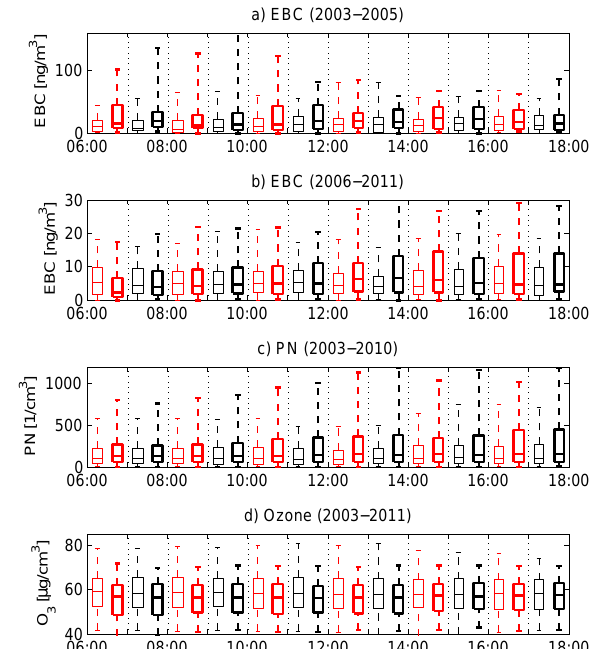
Fig. 5. Box and whisker plots of EBC, particle number concentra- tion for the 60nm size bin, and ozone measured at Zeppelin for each hourly interval between 06:00 a.m. and 06:00 p.m.UTC for the two categories describing whether ships are present in the harbor, or not. The boxes with the thin lines show the data when there are no ships; the boxes with the thick lines the data when there are ships. For clarity of presentation, the colors alternate every hour. Data shown are for summer (June, July, August) during the years given in each panel